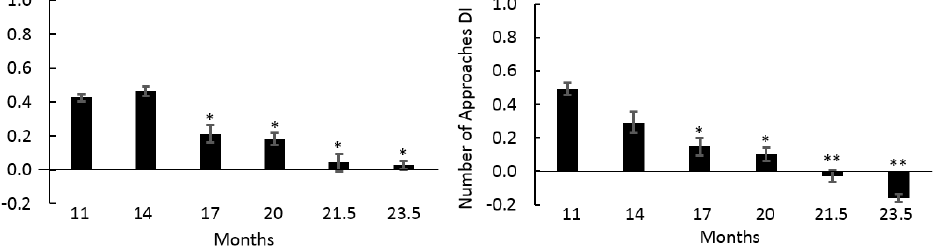
Figure 2. Locomotor and cognitive parameters during aging. ( A ) Locomotor parameters: total distance, resting time, mean speed, and max speed measured in open arena during aging. ( B ) cognitive parameters: latency to first exit, exit number, and exploring time measured in emergence, and ( C ) cognitive parameters: discrimination index (DI) of the time of approaches and of the number of approaches measured in NOR test. Statistical results were performed by Anova for repeated measures: * vs. T0, # vs. T1, $ vs. T2, and £ vs. T3. For all symbols reported p < 0.05 (*, #, $, £), p < 0.01 (**, ##, $$, ££), p < 0.001 (***, ###, $$$, £££).